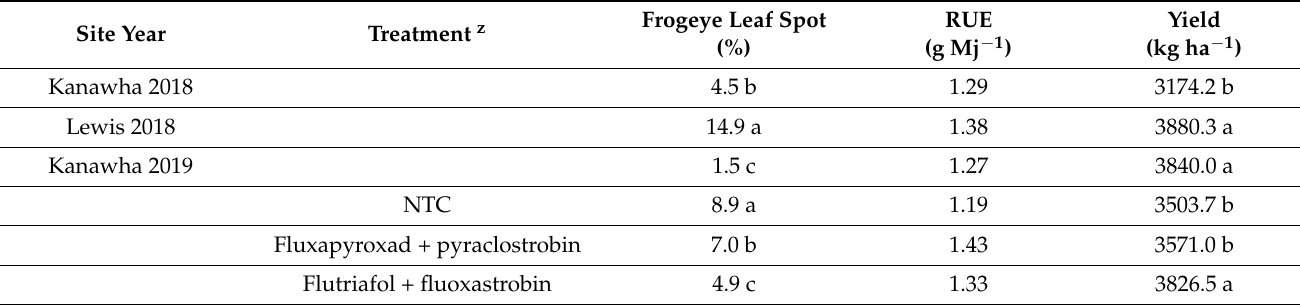
Table 3. Least square means y of yield, frogeye leaf spot severity, and radiation use efficiency (RUE) recorded in field experiments in Kanawha and Lewis county Iowa in 2018 and 2019.